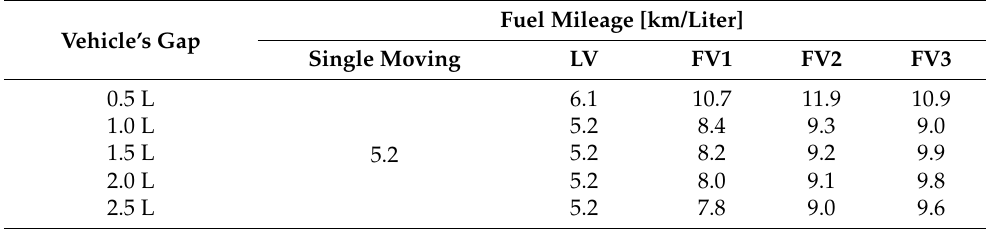
Table 4. Fuel mileage of each model vehicle platooning compared to the single moving vehicle (SV).